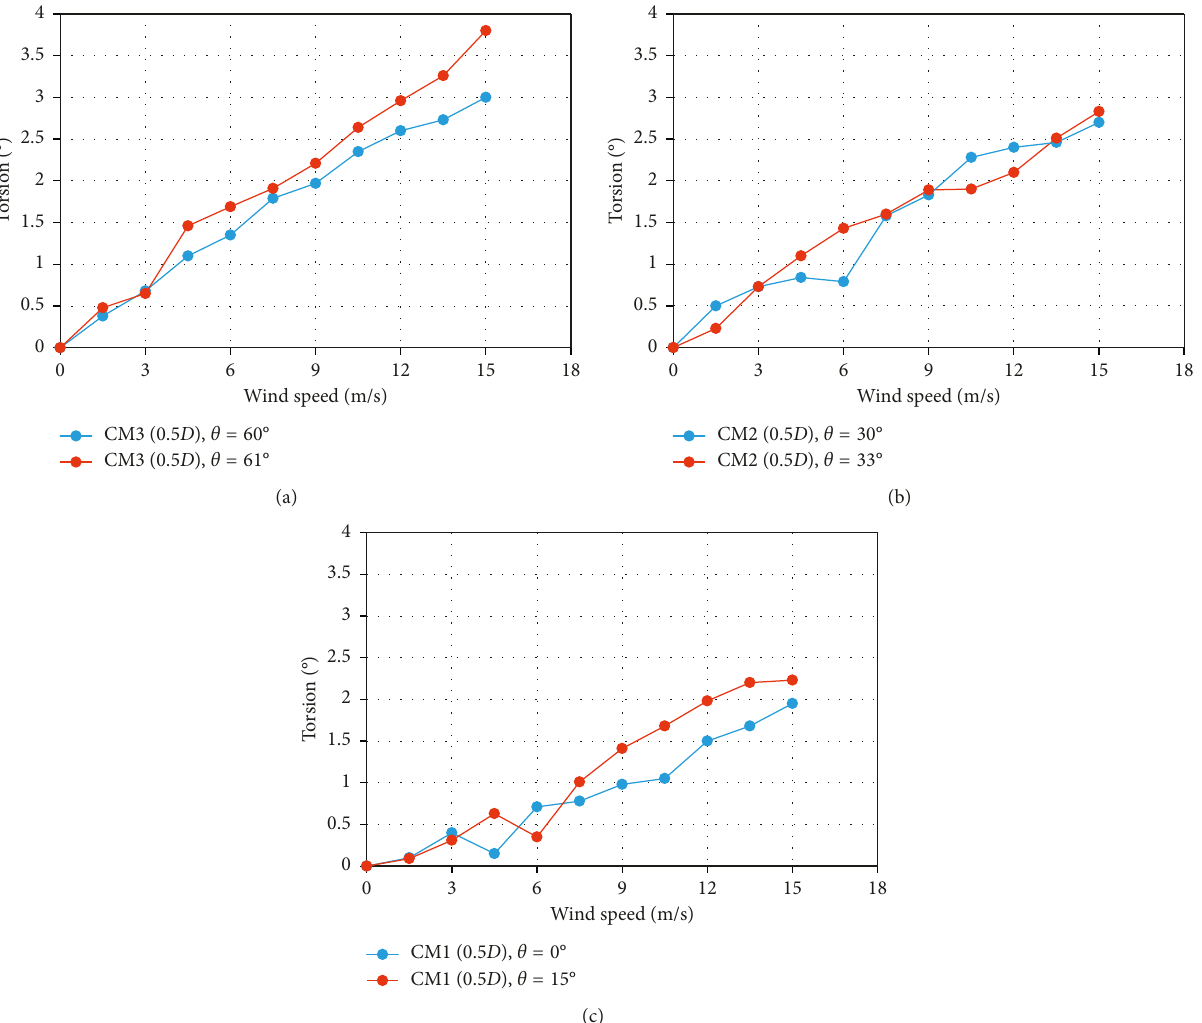
Figure 11: Variation of mean torsional response with wind speed for cable models with 0.5D ice thickness: (a) CM3 at θ � 60 ° and θ � 61 ° ; (b) CM2 at θ � 30 ° and θ � 33 ° ; (c) CM1 at θ � 0 ° and θ � 15 °